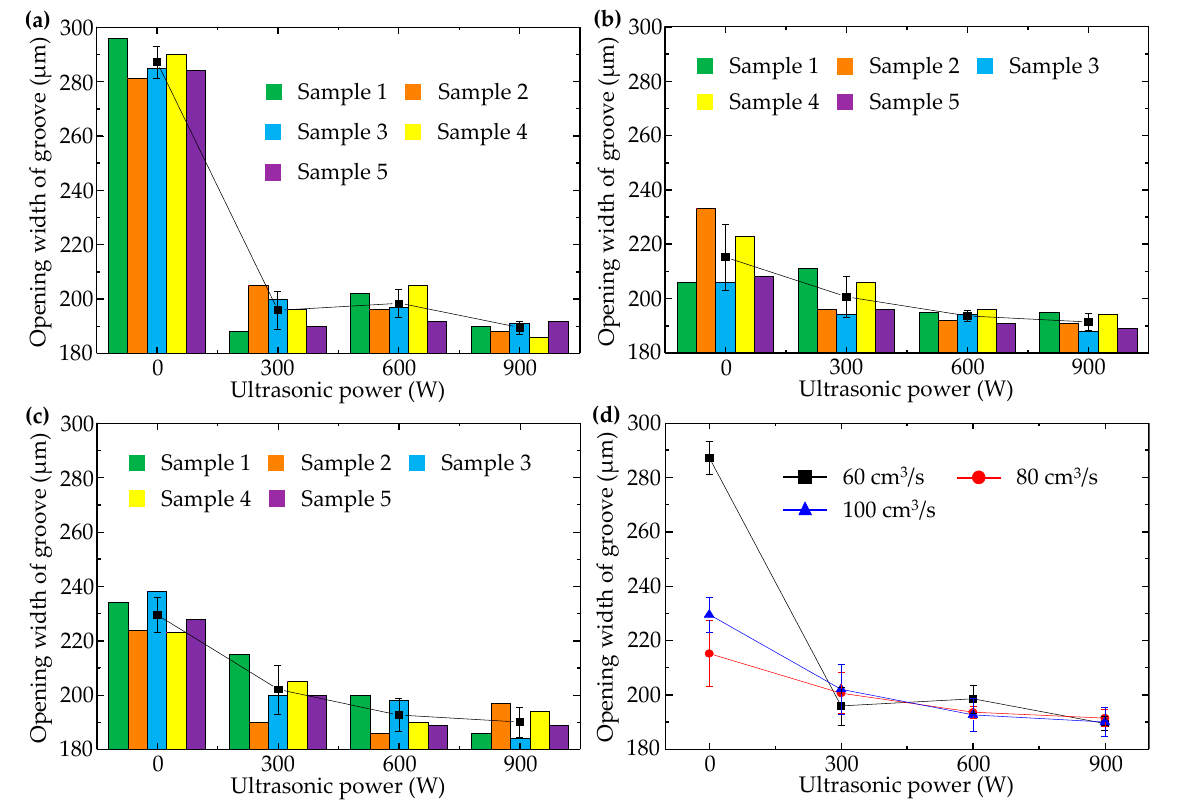
Figure 8. Variation of opening width of the transverse micro groove with ultrasonic power when injection pressure was 60 MPa and injection speeds were ( a ) 60 cm 3 /s, ( b ) 80 cm 3 /s, and ( c ) 100 cm 3 /s. ( d ) Comparison of the average values of each group. Moreover, ultrasonic vibration makes the effect of injection speed on opening width of the transverse micro groove become weak. As shown in Figure 8d, corresponding points of the three curves with injection speeds of 60, 80, and 100 cm 3 /s almost coincided with each other when ultrasonic power was 900 W. This indicates that the promoting ef- fect of ultrasonic vibration surpasses the promoting effect of high speed on micro trans- verse groove formation.